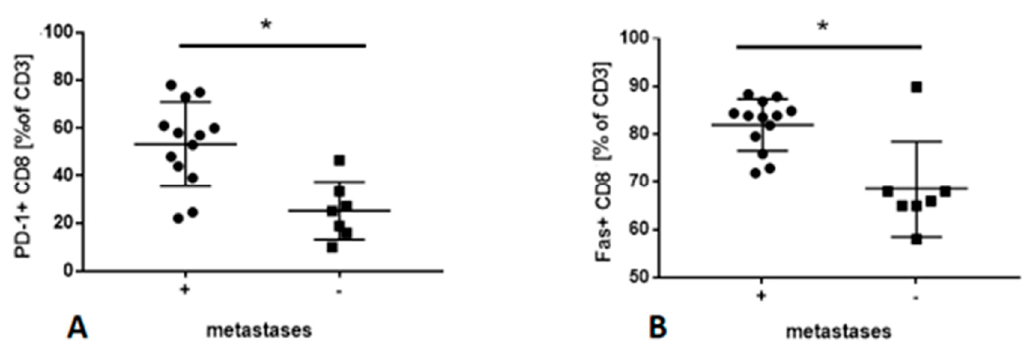
Figure 3. A ) The significant differences in the frequency of PD-1+ CD8 T cells in PB in patients with confirmed metastases in LNs and in patients without confirmed metastases in LNs, * p = 0.0034. B ) The significant differences in the frequency of Fas+ CD8 T cells in PB in patients with confirmed metastases in LNs and in patients without confirmed metastases in LNs, * p = 0.0078. Data are expressed as median with interquartile range. *Differences between groups are significant in Mann–Whitney U-test.